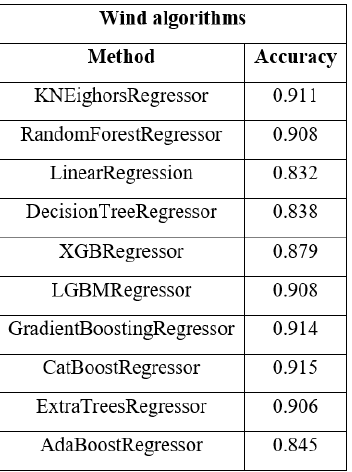
Figure 4. Scoring algorithms ML wind